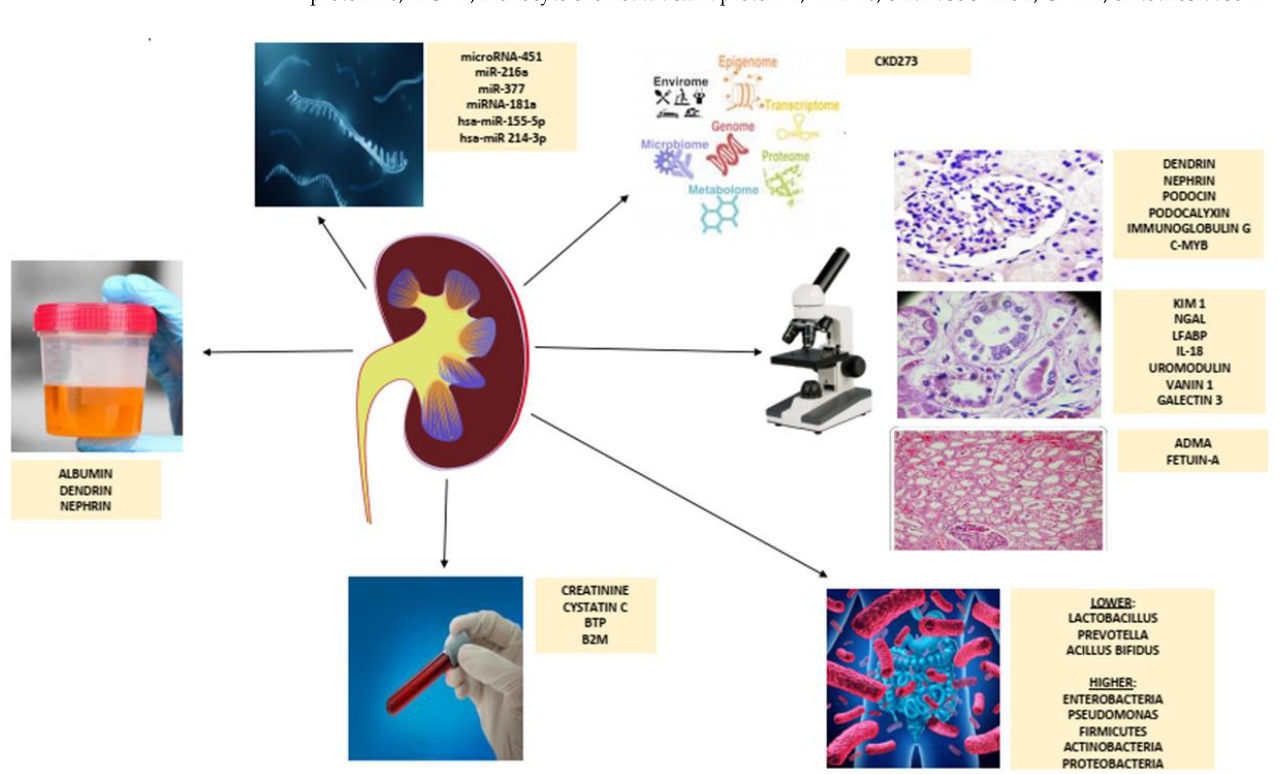
Figure 1. Schematic overview of diagnostic tools in an early detection of chronic kidney disease.